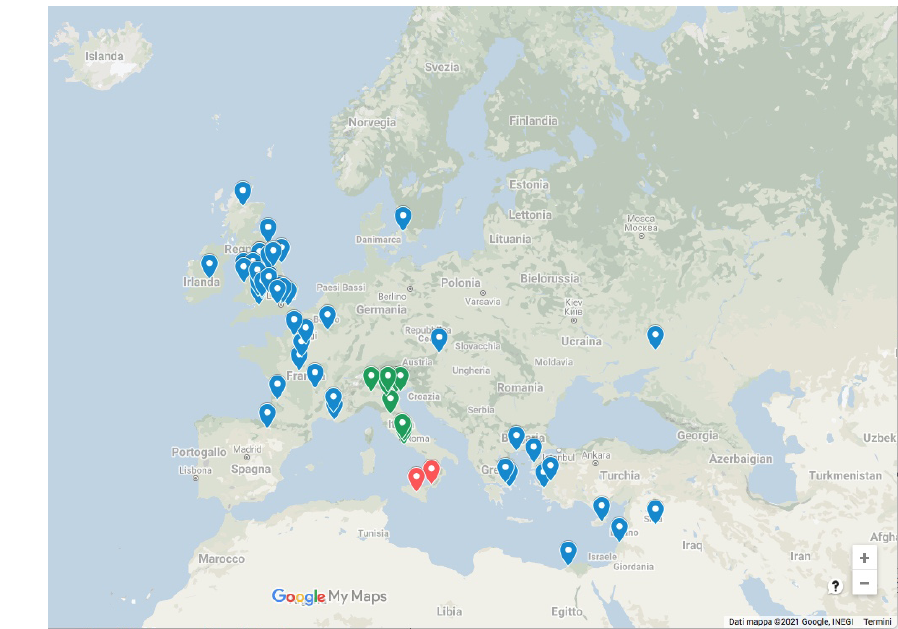
Figure 2. Shakespeare’s locations. A map generated with © Google Maps by the author. The icons in green and red indicate the plays located in Italy, with those in red referring to the ones based in Sicily. © 2020 Google.